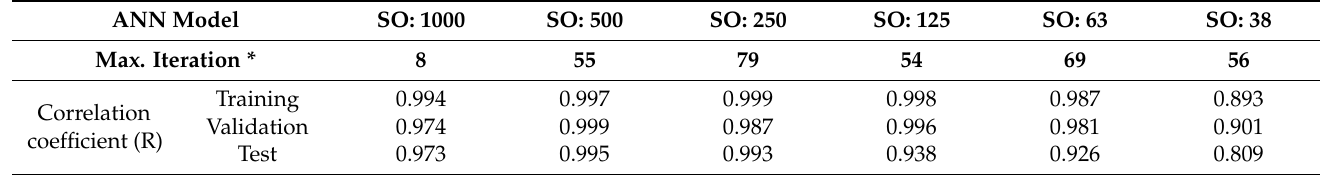
Table 1. Training results of six PPC prediction ANN